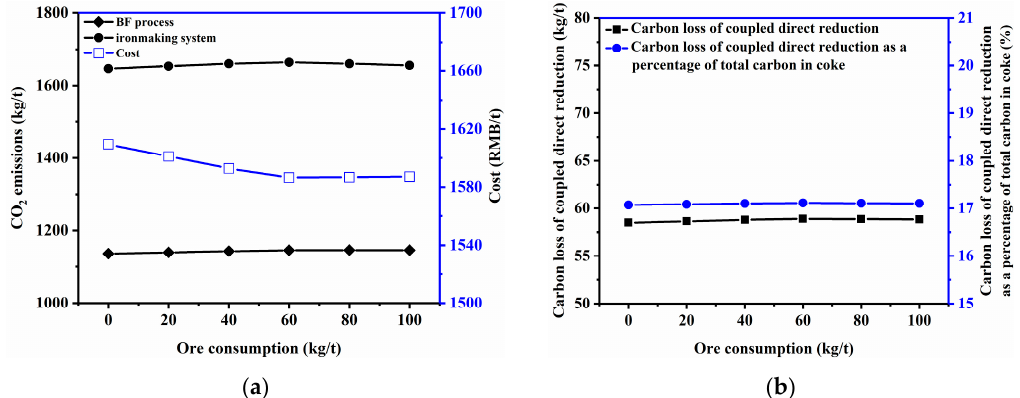
Figure 7. ( a ) Effect of ore consumption on cost and CO 2 emissions; ( b ) Effect of ore consumption on carbon loss of coupled direct reduction and its percentage of total carbon in coke.